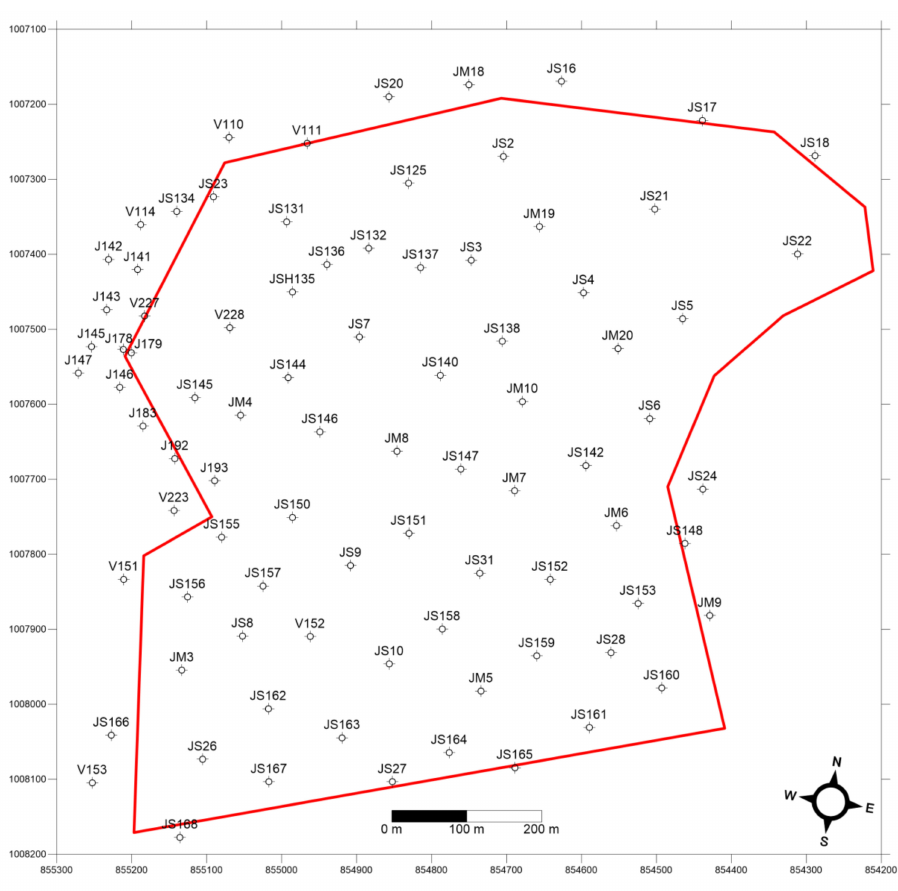
Figure 2. Deposit demarcation and exploratory drill holes used in our